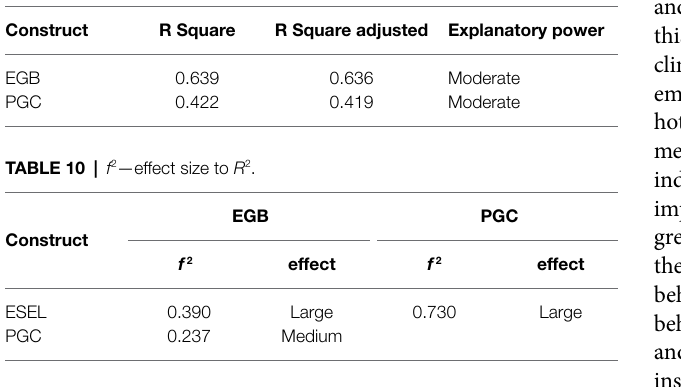
TABLE 9 | Coefficient of the determinant ( R 2 ).